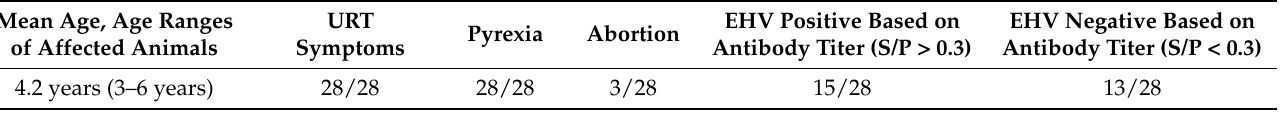
Table 1. Overview of symptoms and ELISA (S/P cutoff 0.3) results.